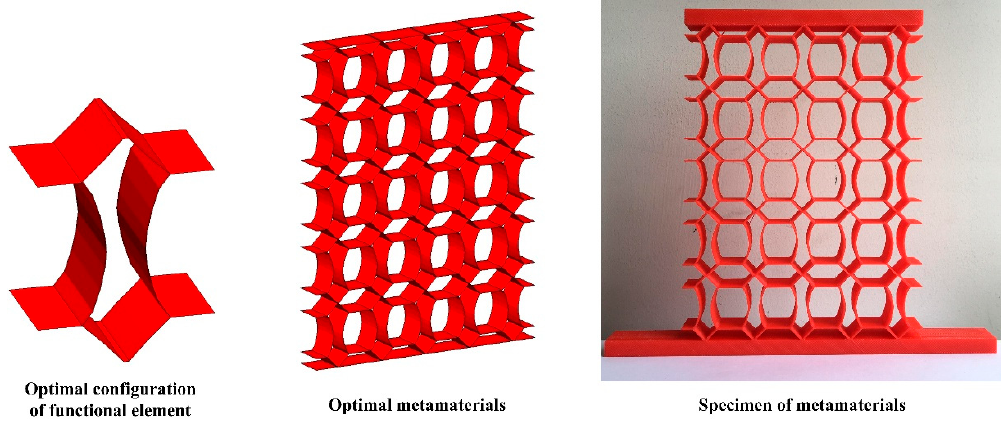
Figure 8. Optimal functional element, metamaterials and prototype with corresponding Poisson’s ratio 𝜈 = +1.0 .